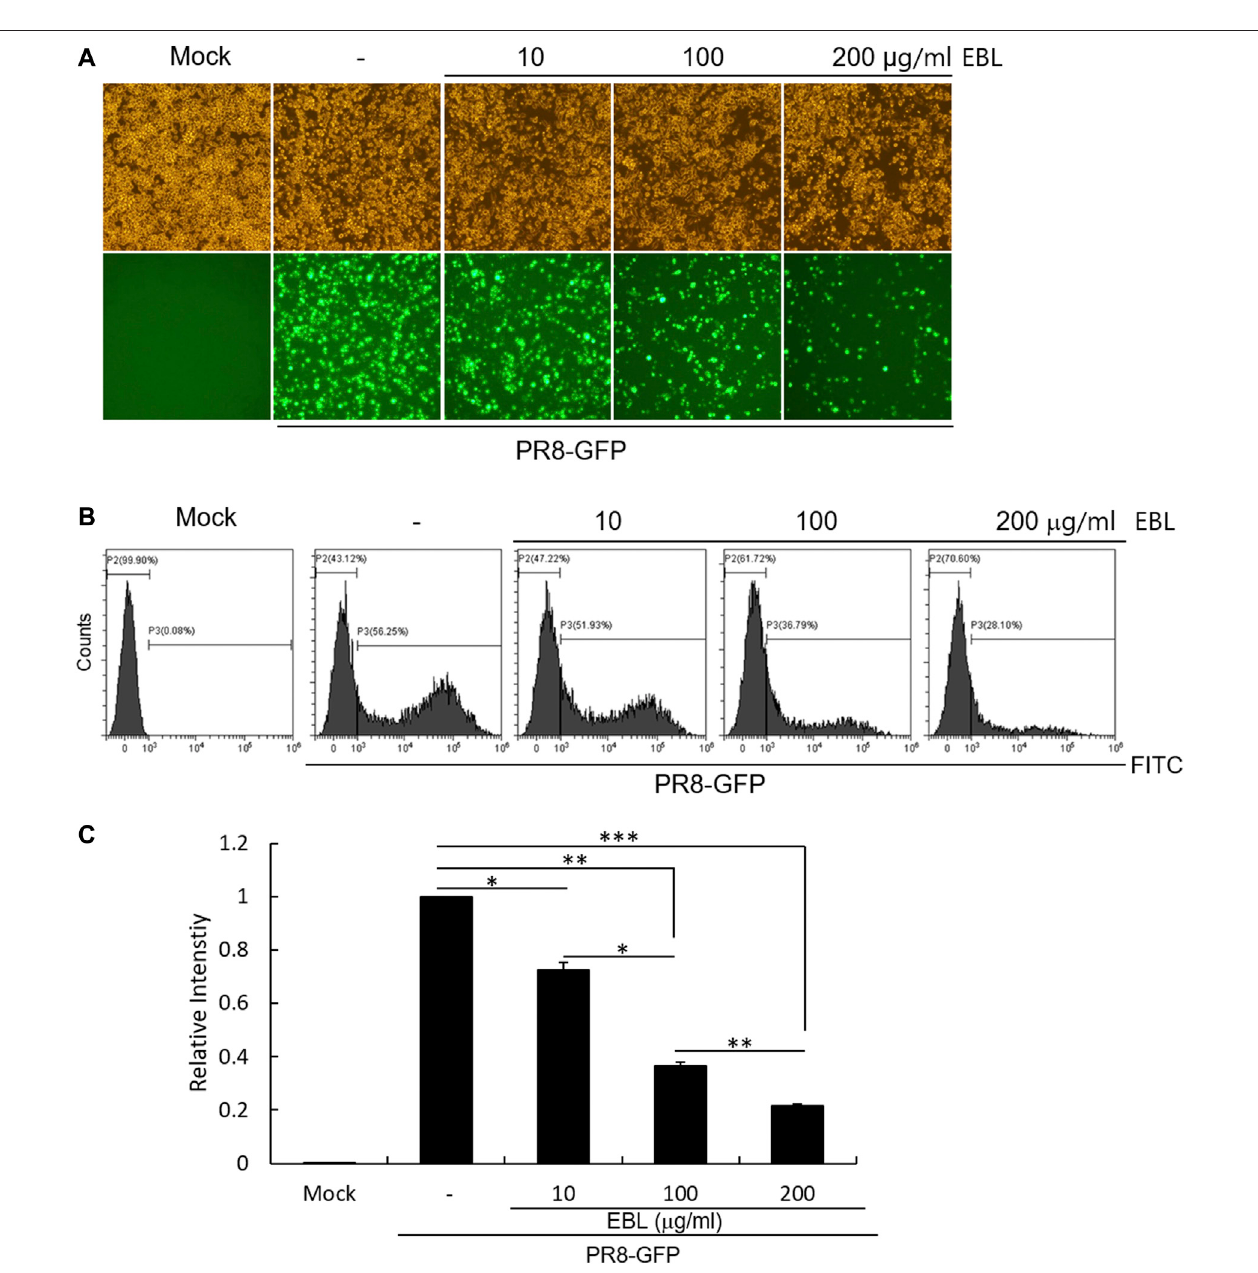
FIGURE 2 | EBL exerted the inhibitory effect on in fl uenza A/PR/8/34-GFP viral infection in a dose-dependent manner. EBL (0, 10, 100, or 200 μ g/ml) was mixed with PR8-GFP IAV for 1 h at 4 ° C. The mixtures were added to RAW 264.7 cells for 2 h at 37 ° C. After washing with PBS, the cells were further incubated for 24 h. (A) Bright fi eld and fl uorescence images were captured with the fl uorescent microscope at a ×200 magni fi cation. (B) After fi xing with 4% paraformaldehyde and resuspendedinPBS,thecellswereanalyzedforGFPexpressionbyFACS. (C) LevelsofGFPexpressionweredepictedasrelativeintensitiescomparedtothoseof the control PR8-GFP IAV. The data represent the mean ± SD based on three independent experiments. Statistical signi fi cance was assessed via an unpaired Student T-test. *** p < 0.0001, ** p < 0.001, and * p < 0.005.